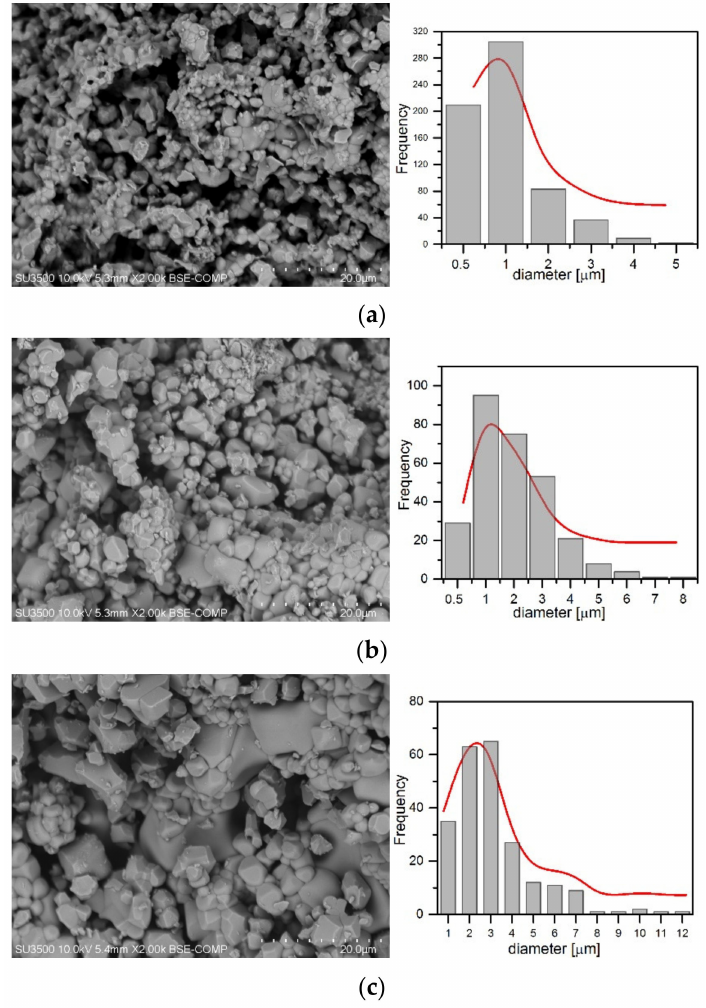
Figure 2. SEM images and histograms of samples ( a ) CaMo 0.5 W 0.5 O 4 :Eu 3+ 0.005 /Tb 3+ 0.005 , ( b ) CaMo 0.9 W 0.1 O 4 :Eu 3+ 0.009 /Tb 3+ 0.001 , ( c ) CaMo 0.1 W 0.9 O 4 :Eu 3+ 0.001 /Tb 3+ 0.009 .